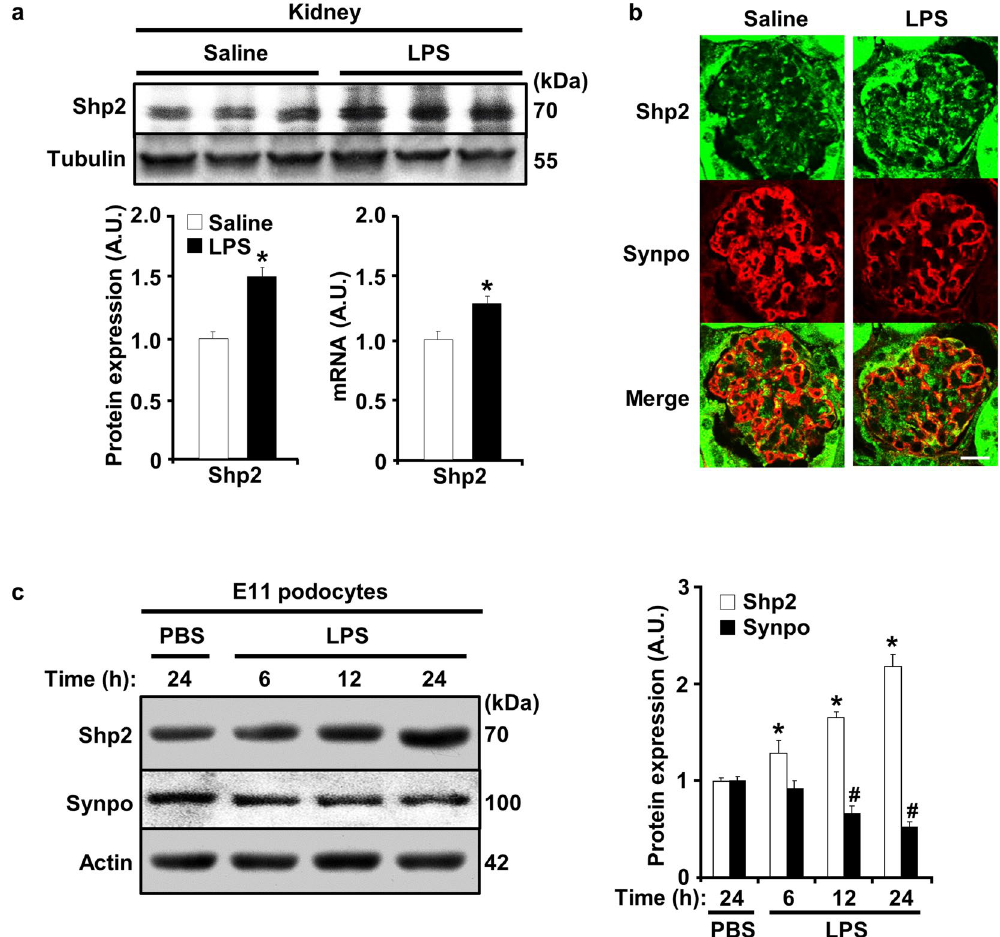
Figure 1. LPS treatment increases renal and podocyte Shp2 expression. ( a ) Immunoblots of Shp2 and tubulin in total kidney lysates. Control (saline, n = 6) and LPS-injected (n = 6) wild-type male mice were sacrificed 24 hours after injection. Representative images are shown and each lane represents an animal. Shp2 protein expression (left, normalized to tubulin) and mRNA (right, normalized to Tbp ) presented in bar charts as means + SEM. * p < 0.05 indicates a significant difference between saline and LPS-treated mice. ( b ) Co- immunostaining of Shp2 (green) and synaptopodin (Synpo, red) in kidney sections from saline and LPS-treated wild-type mice. Scale bar: 20 µ m. ( c ) Differentiated E11 podocytes were treated with PBS for 24 hours and with LPS for 6, 12 and 24 hours. Cell lysates were immunoblotted for Shp2, synaptopodin, and actin. Protein expression was normalized to actin and presented in a bar chart as means + SEM from three independent experiments. * p < 0.05 and # p < 0.05 indicate a significant difference between PBS (24 h) and LPS-treated groups for Shp2 and synaptopodin, respectively. A.U., arbitrary